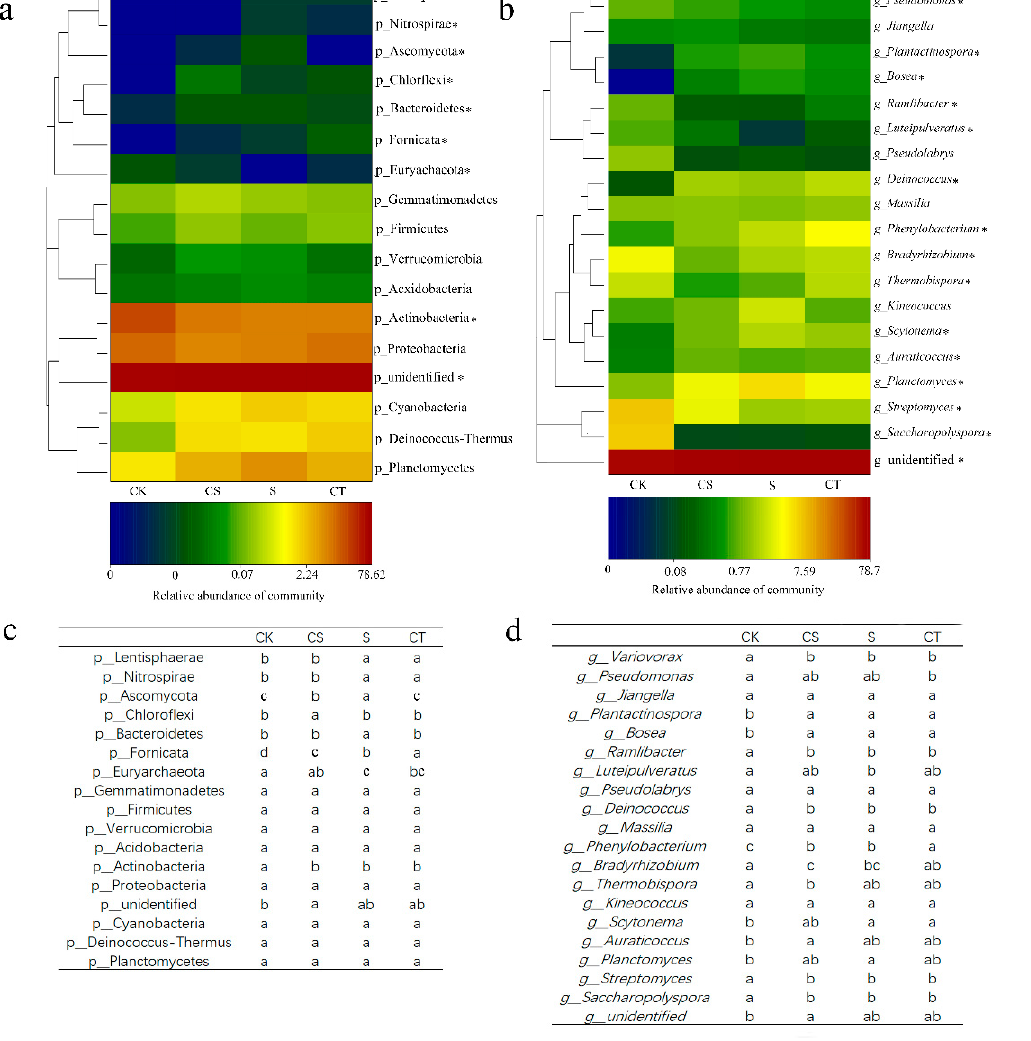
Figure 4. Comparison of the phoD microbial community composition in different treatments at the phylum ( a ) and genus levels ( b ). Different letters in the same column indicate a significant difference ( p < 0.05) (( c ): at phylum level, ( d ): at genus